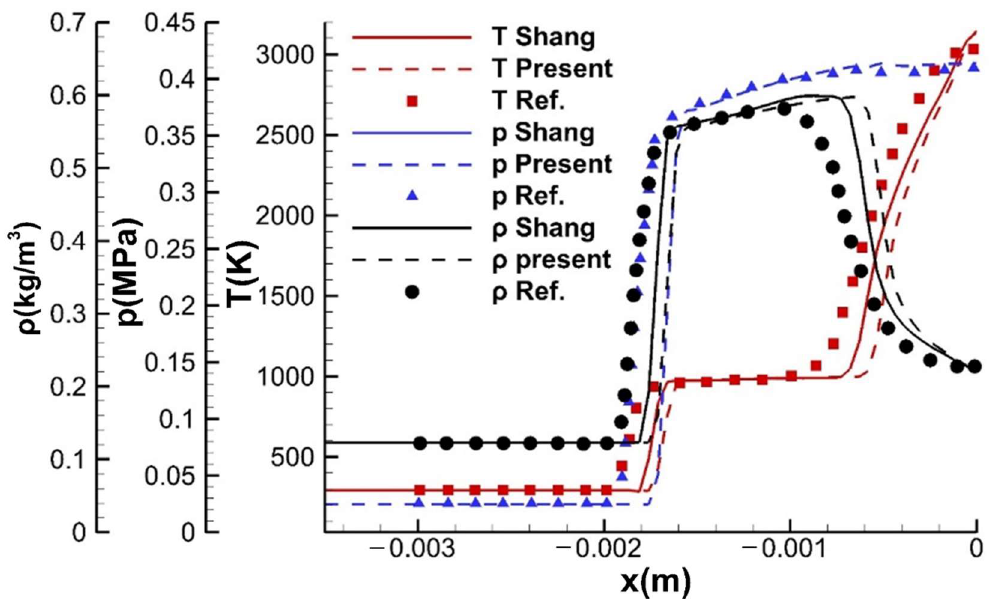
Energies 2021 , 14 , x FOR PEER REVIEW Figure 13. Pressure, temperature, and density distribution along the stagnation line of the sub-detonative combustion.